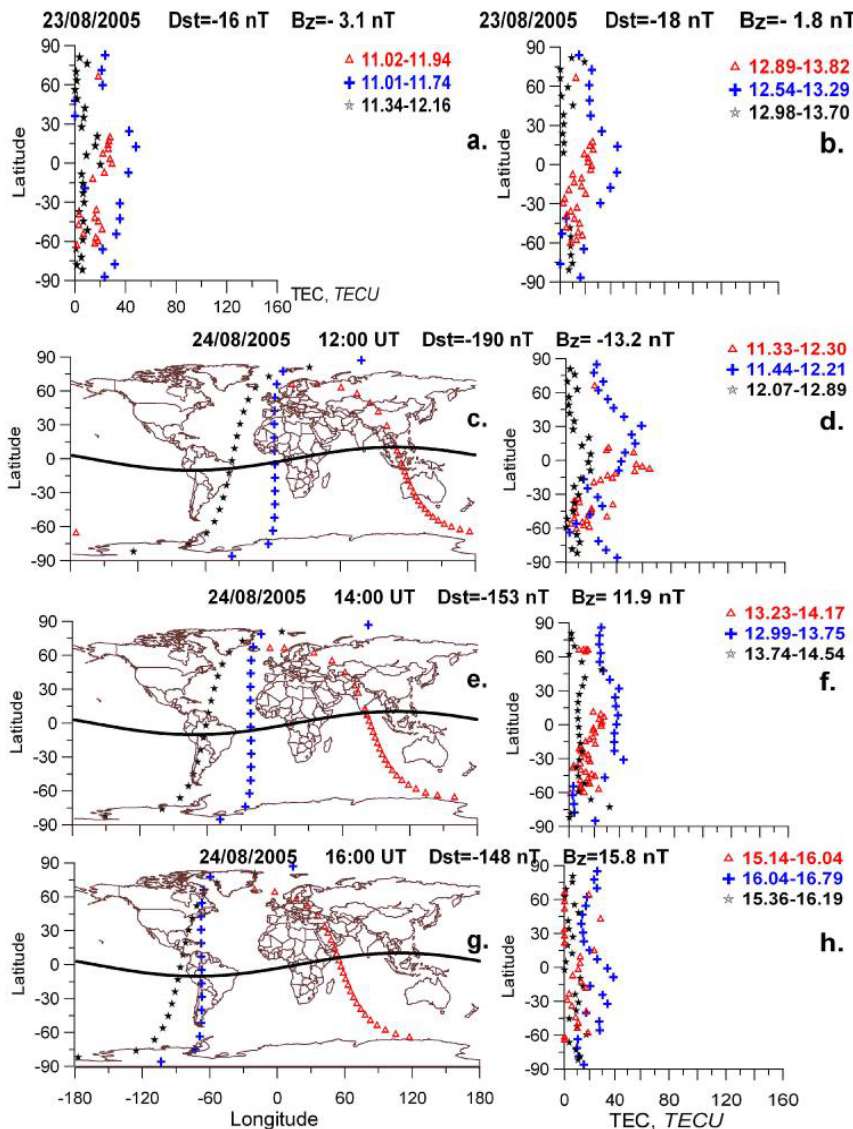
Fig. 5. The same as in Fig. 3 but for quiet day 23 August 2005 (a) , (b) and the geomagnetic storm on 24 August 2005 (c–h) . The satellites pass near the following sectors: Jason-1 ∼ 19:30LT, CHAMP ∼ 12:00LT, SAC-C ∼